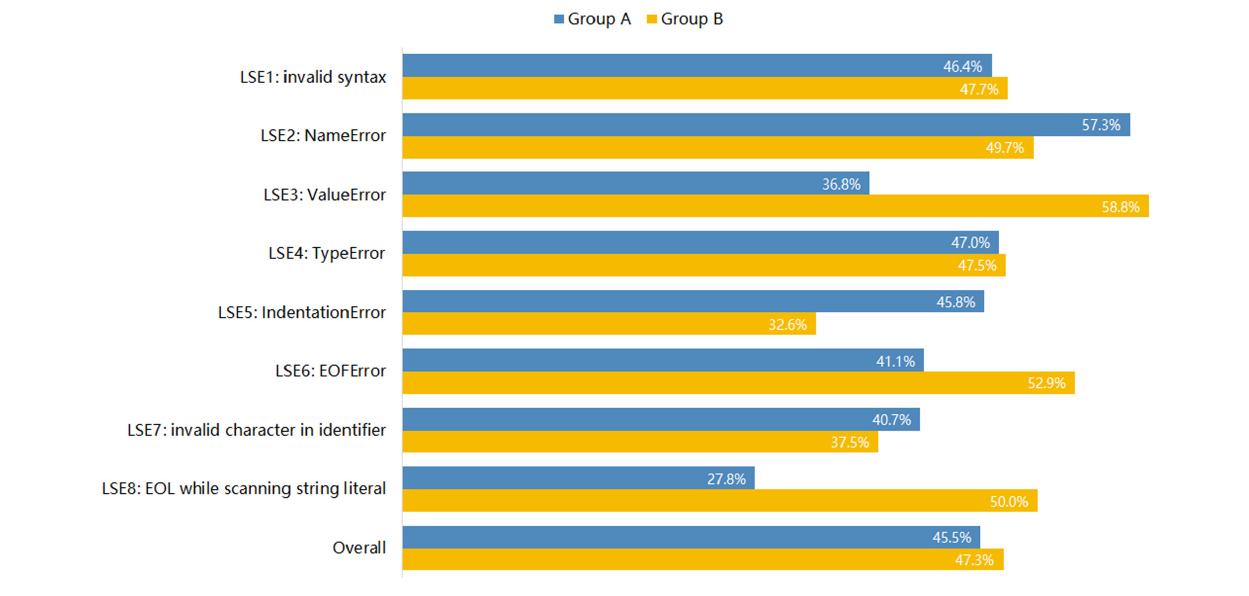
FIGURE 2 | Improvement Rates of LSEs with EPEMs.